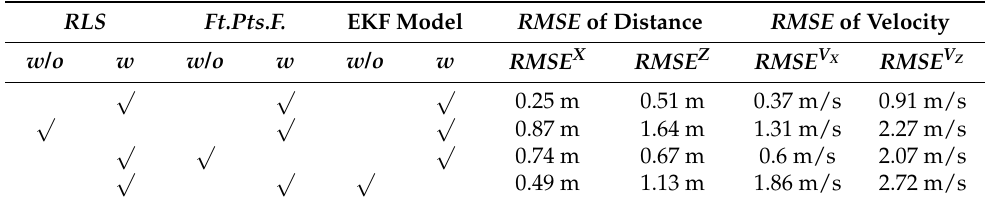
Table 4. Quantitative comparison of different versions of our method in ablation study. RLS indicates our region-level segmentation method, Ft.Pts.F. denotes feature-point filtering method, EKF model represents the designed Kalman filter in Section 3.2.2, w/o means without and w is short for with. A tick mark indicates the corresponding term is included in the counterpart. RLS Ft.Pts.F. EKF Model RMSE of Distance RMSE of Velocity w/o w w/o w w/o w RMSE X RMSE Z RMSE V X RMSE V Z √ √ √ 0.25 m 0.51 m 0.37 m/s 0.91 m/s √ √ √ 0.87 m 1.64 m 1.31 m/s 2.27 m/s √ √ √ 0.74 m 0.67 m 0.6 m/s 2.07 m/s √ √ √ 0.49 m 1.13 m 1.86 m/s 2.72